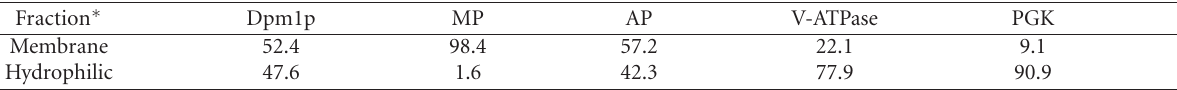
Table 2. Quantification of yeast proteins fractionated with the Mem-PER reagents in Figure